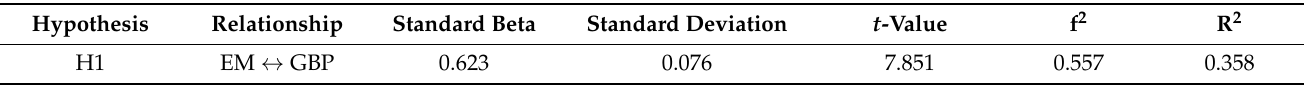
Table 5. The results of the structural